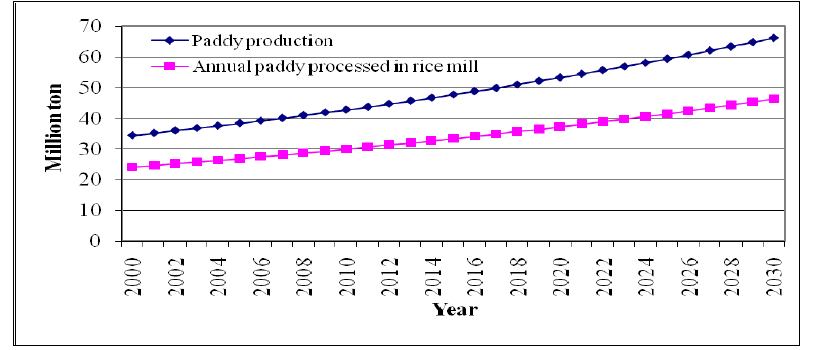
Figure 2. Trends of projected rough rice production in Bangladesh by 2030.